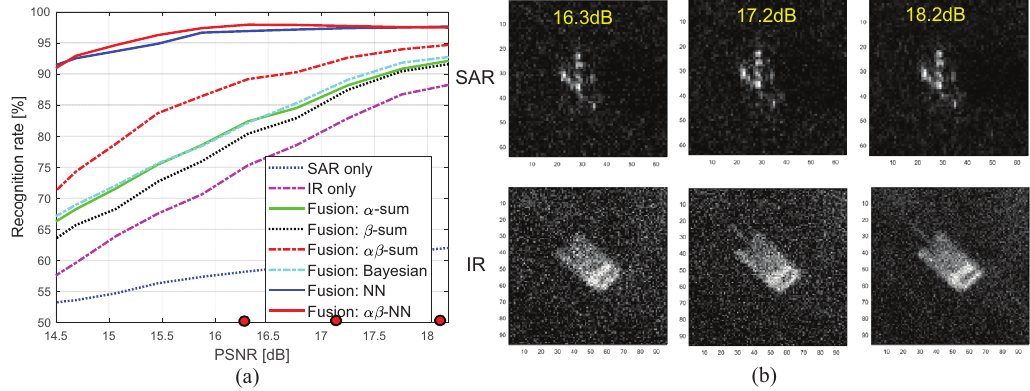
Figure 16. Performance evaluation results for noise variations: ( a ) recognition rate vs signal-to-noise rate [PSNR]; ( b ) test examples of the SAR and IR images at different